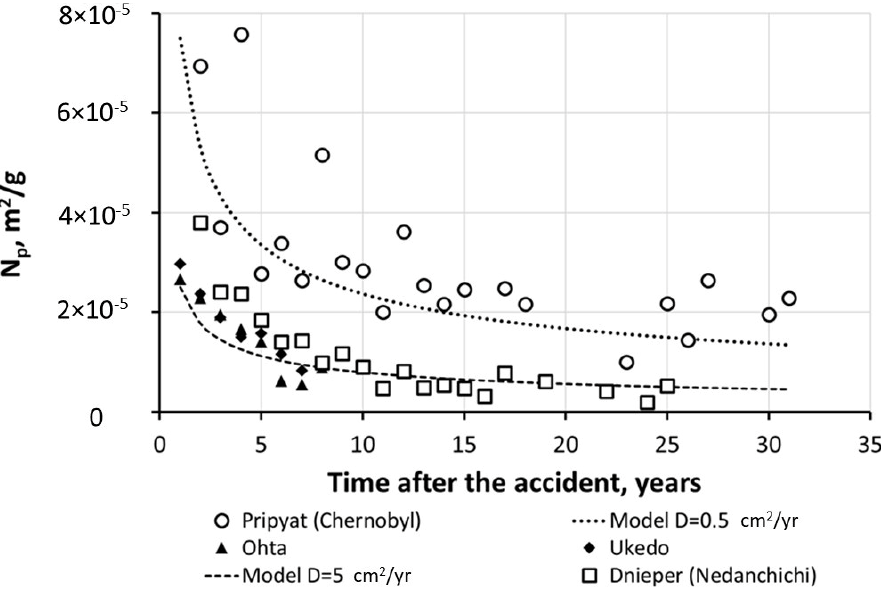
Figure 7. Comparison of time variations in mean annual values of particulate 137 Cs wash-off ratios N p for catchments of Pripyat River at Chernobyl and Dnieper River at Nedanchichi in Chernobyl area (based on data [102]), and for the rivers Ukedo and Ohta in Fukushima area (based on data from [95,97,98]), and comparing with semiempirical diffusional modeling at D eff = 0.5 cm 2 /year and D eff = 5 cm 2 /year [18,79,144]. Reprinted/adapted with permission from Ref. [79]. Copyright year 2022, copyright owner’s name SPRINGER Nature.